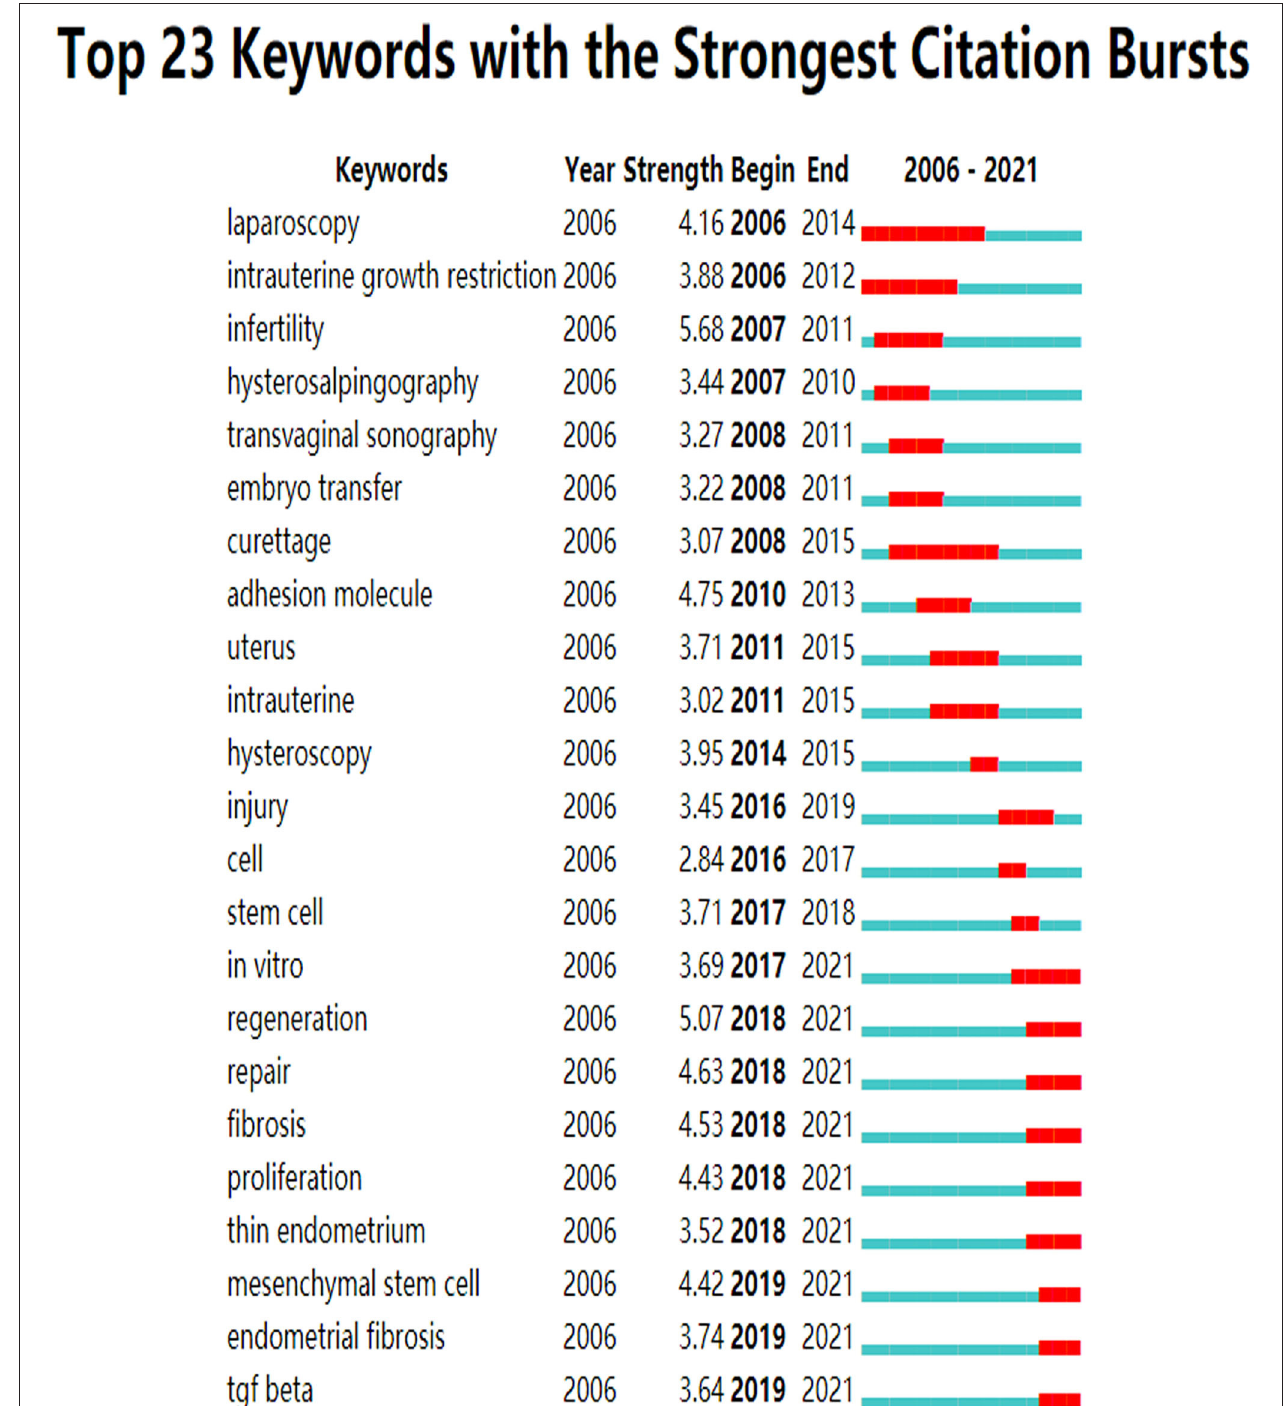
FIGURE 5 | Burst of keywords in CiteSpace. Red indicates the duration of a burst, indicating that keywords are frequently quoted, while green indicates keywords that are not frequently quoted.